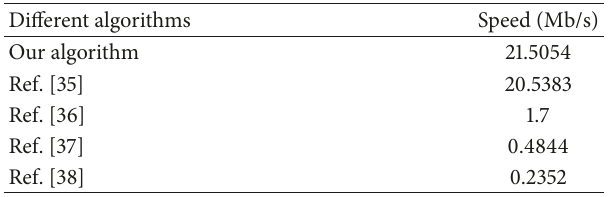
Table 8: Algorithm Speed